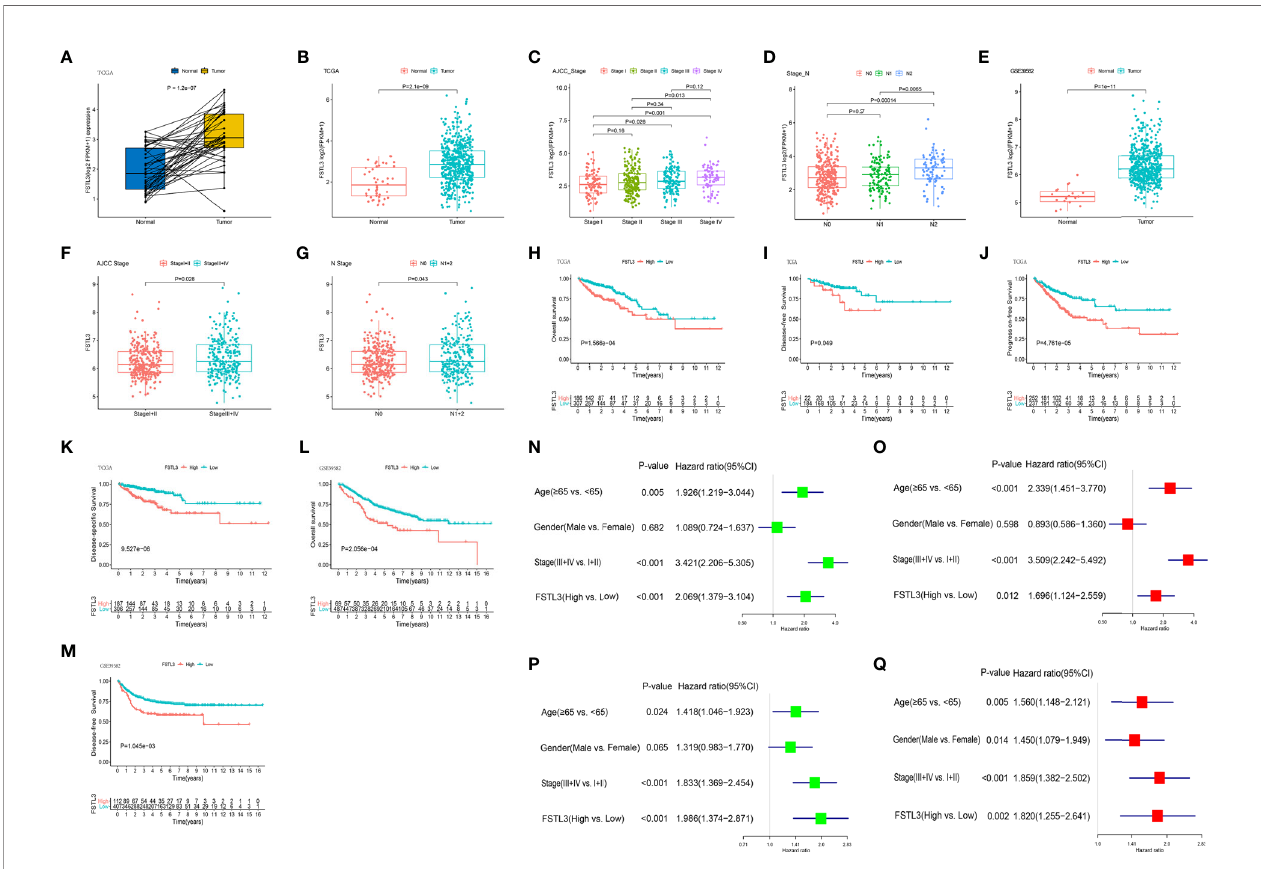
FIGURE 6 | Overexpression of FSTL3 correlated with tumor malignancy in CRC. (A) FSTL3 mRNA expression between normal and paired tumor samples in the TCGA cohort. (B) FSTL3 mRNA expression between total normal and tumor samples in the TCGA cohort. (C, D) FSTL3 mRNA expression is in remarkable association with AJCC stage (C) and N stage (D) . (E – G) Similar results were obtained in GEO GSE39582 cohort. (H – K) Higher FSTL3 mRNA expression was notably correlated with OS (H) , disease-free survival (I) , progression free survival (J) , as well as disease-speci fi c survival (K) in the TCGA cohort. (L, M) Higher FSTL3 mRNA expression is notably correlated with OS (L) and disease-speci fi c survival (M) in the GSE39582 cohort. (N, O) FSTL3 is an independent unfavorable prognostic factor in TCGA cohort by univariate (N) and multivariate (O) Cox proportional hazards analysis. (P, Q) FSTL3 is an independent unfavorable prognostic factor in GSE39582 cohort by univariate (P) and multivariate (Q) Cox proportional hazards